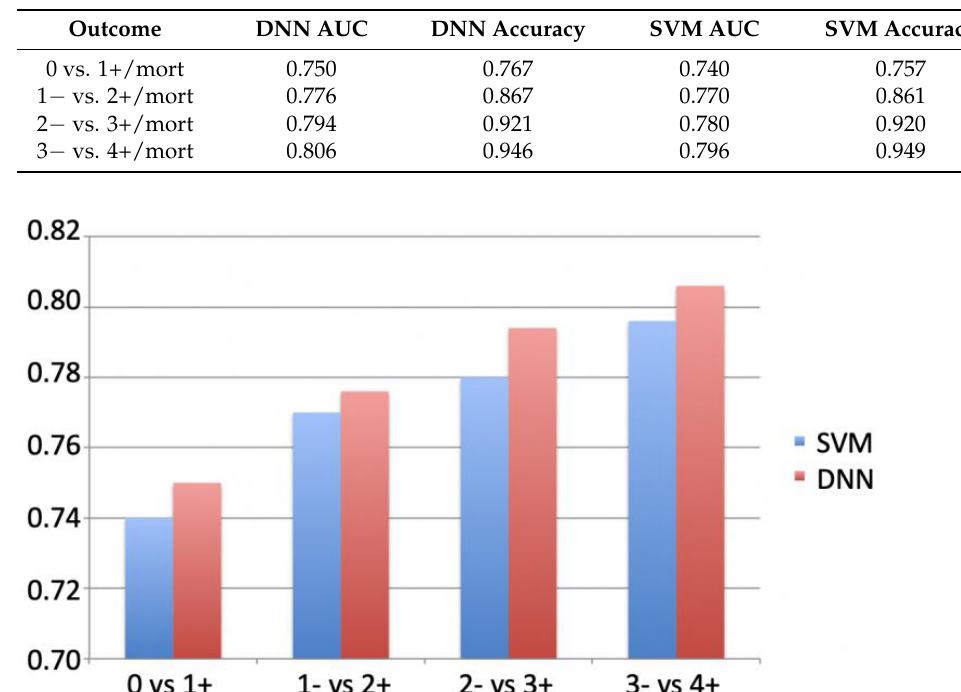
Table 4. Performance of the predictive models on the testing set.